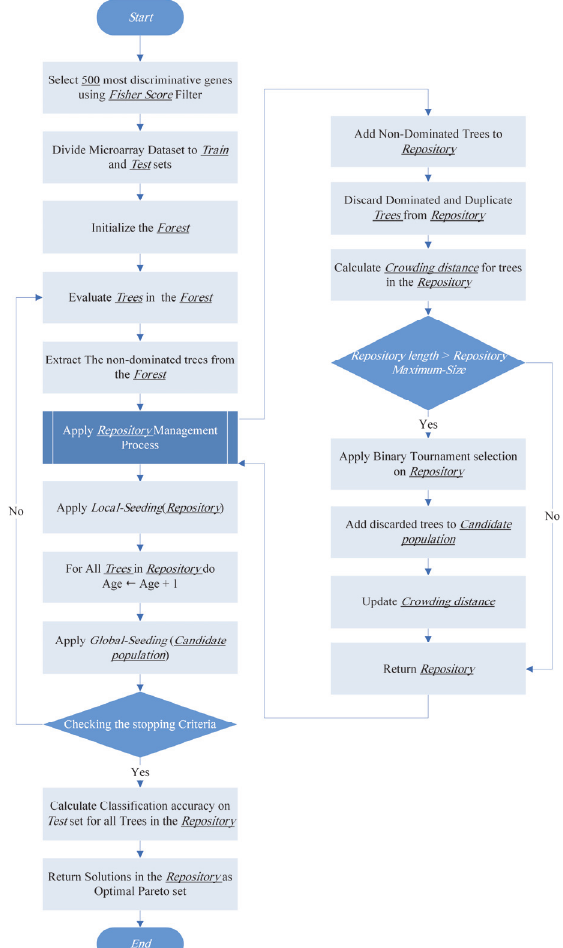
Fig. 1. Proposed GSMOFOA